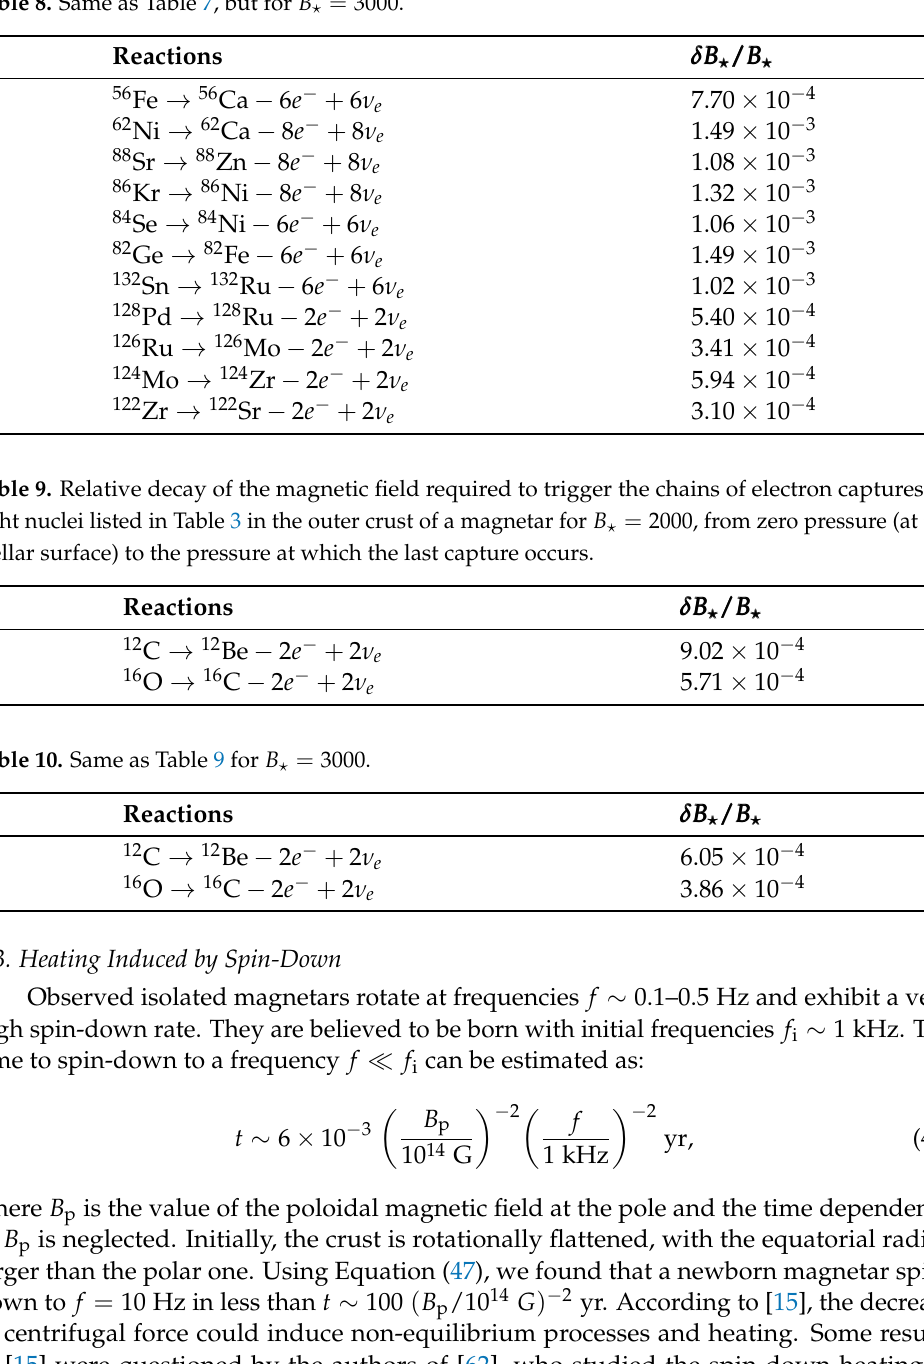
Table 8. Same as Table 7, but for B (cid:63) = 3000.